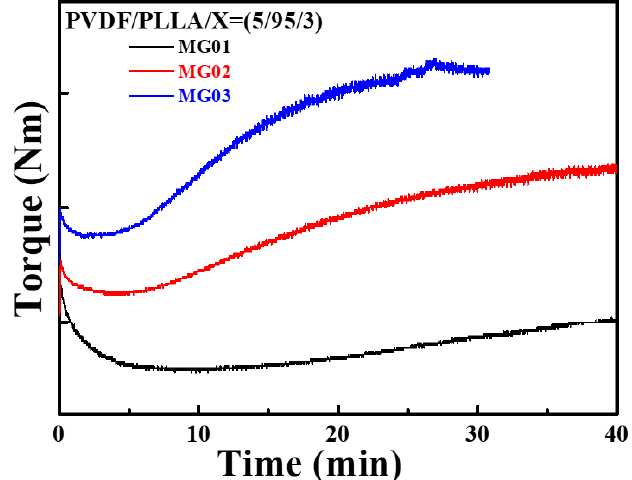
Figure 1. Time–torque curves of the polyvinylidene fluoride/poly( L -lactic acid) (PVDF/PLLA) blends with various compatibilizers and mixing time.